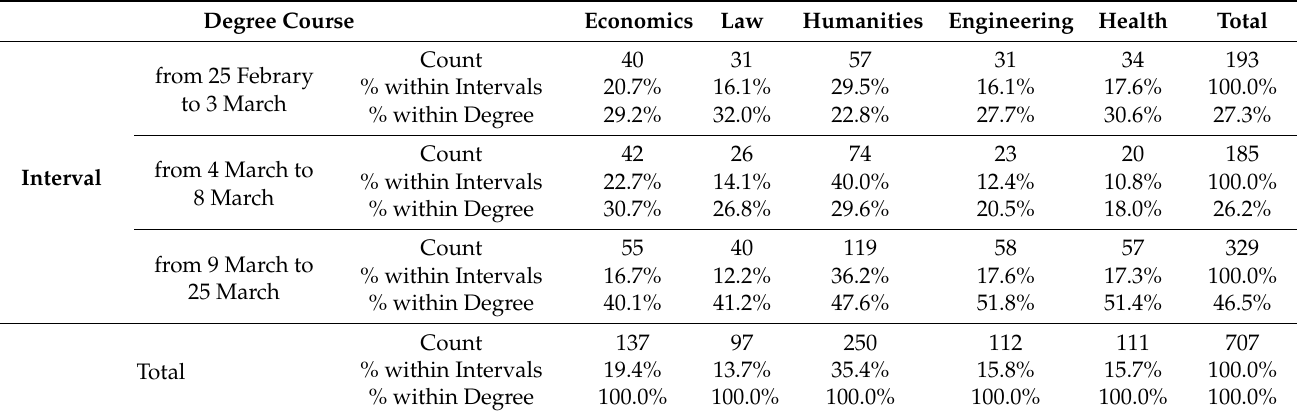
Table 2. Time interval in relation to participants’ degree course.